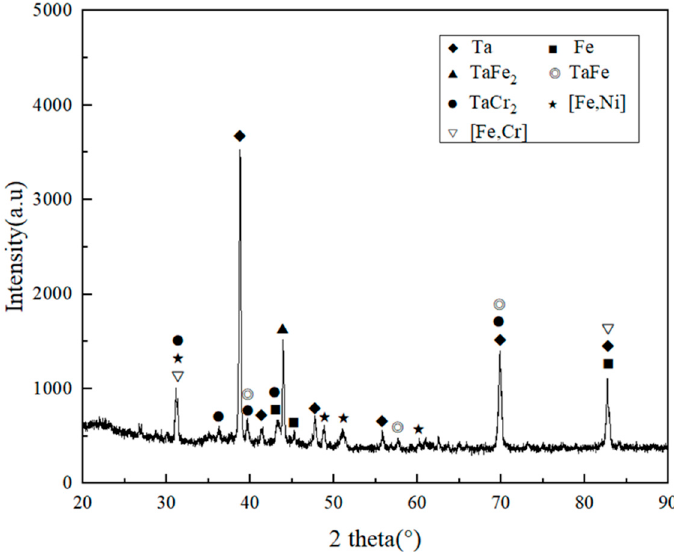
Figure 7. XRD analysis of the welded joint.